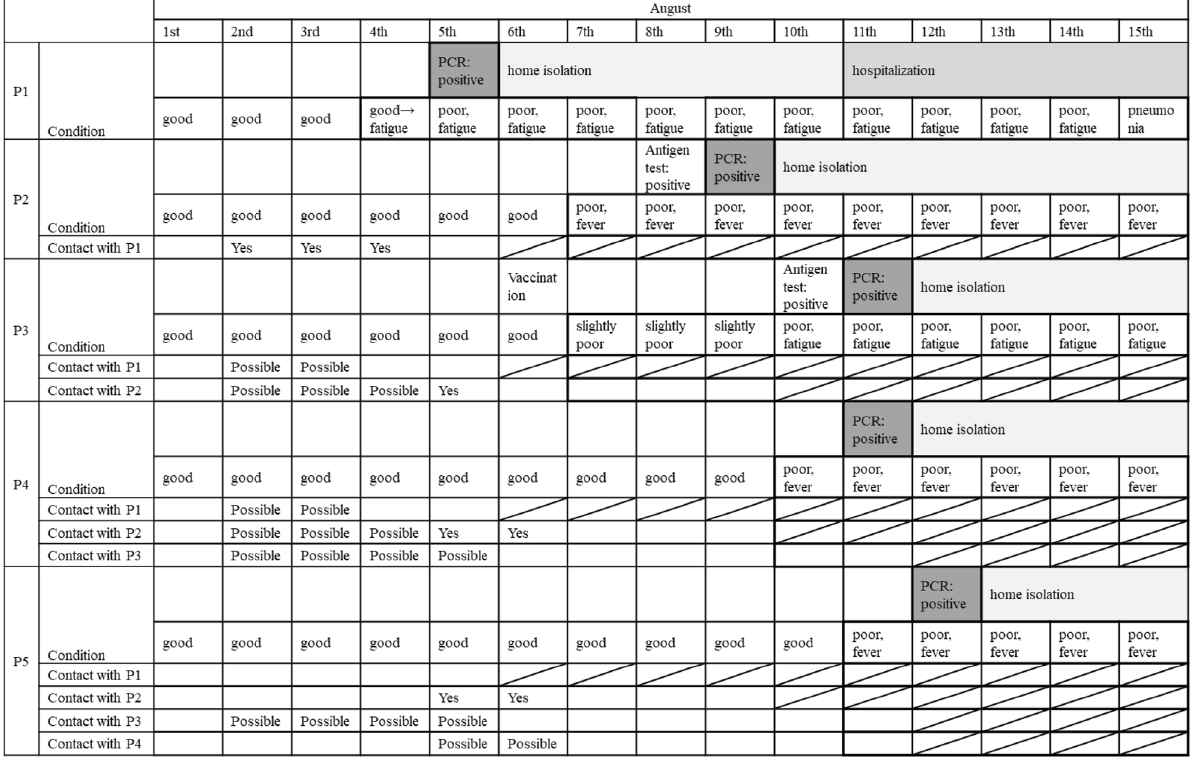
Figure 3. Time course of the emergence of infected patients.